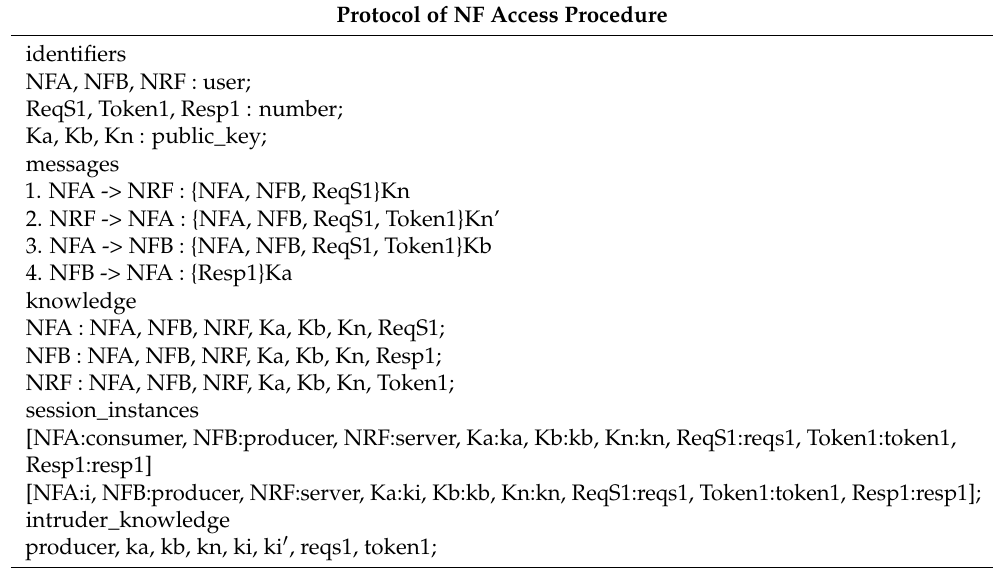
Table 7. CAS+ description of the NF service access procedure. Protocol of NF Access Procedure